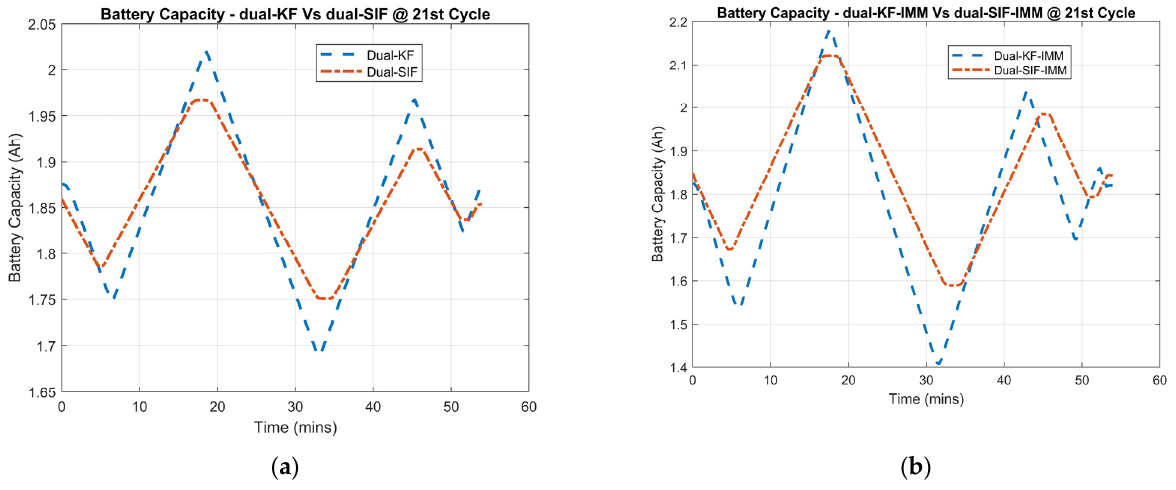
Figure 6. ( a ) Dual-KF and dual-SIF battery capacity estimates at cycle 21. ( b ) Dual-KF-IMM and dual-SIF-IMM battery capacity estimates at cycle 21.